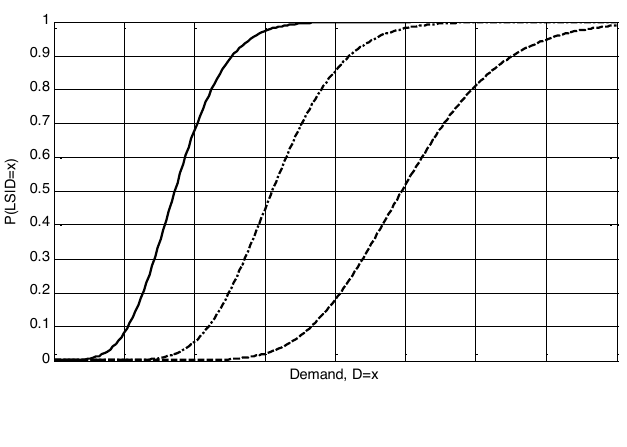
Figure 2. Suite of fragilities for